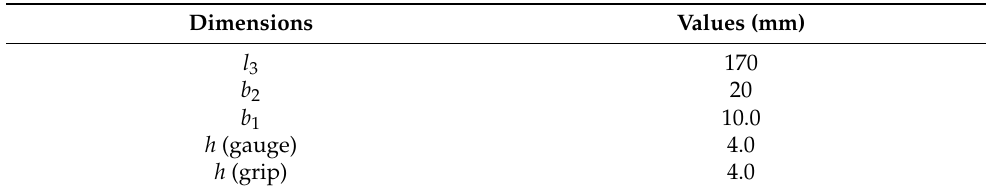
Table 4. Dimensions to be measured and their nominal value.